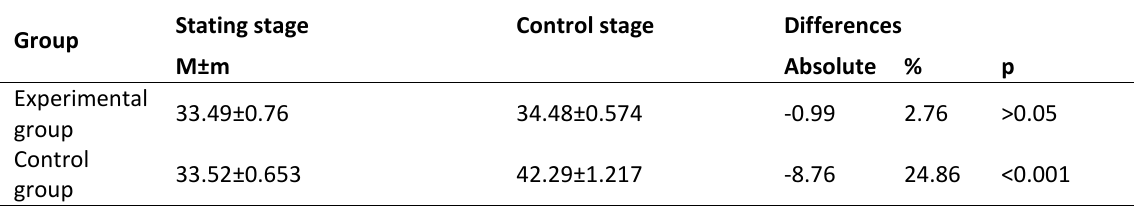
Table 2. Indicators of students’